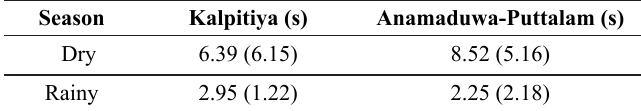
Table 3: Average depth to the water table (m) and standard deviation (s) during the dry and the rainy seasons (n =